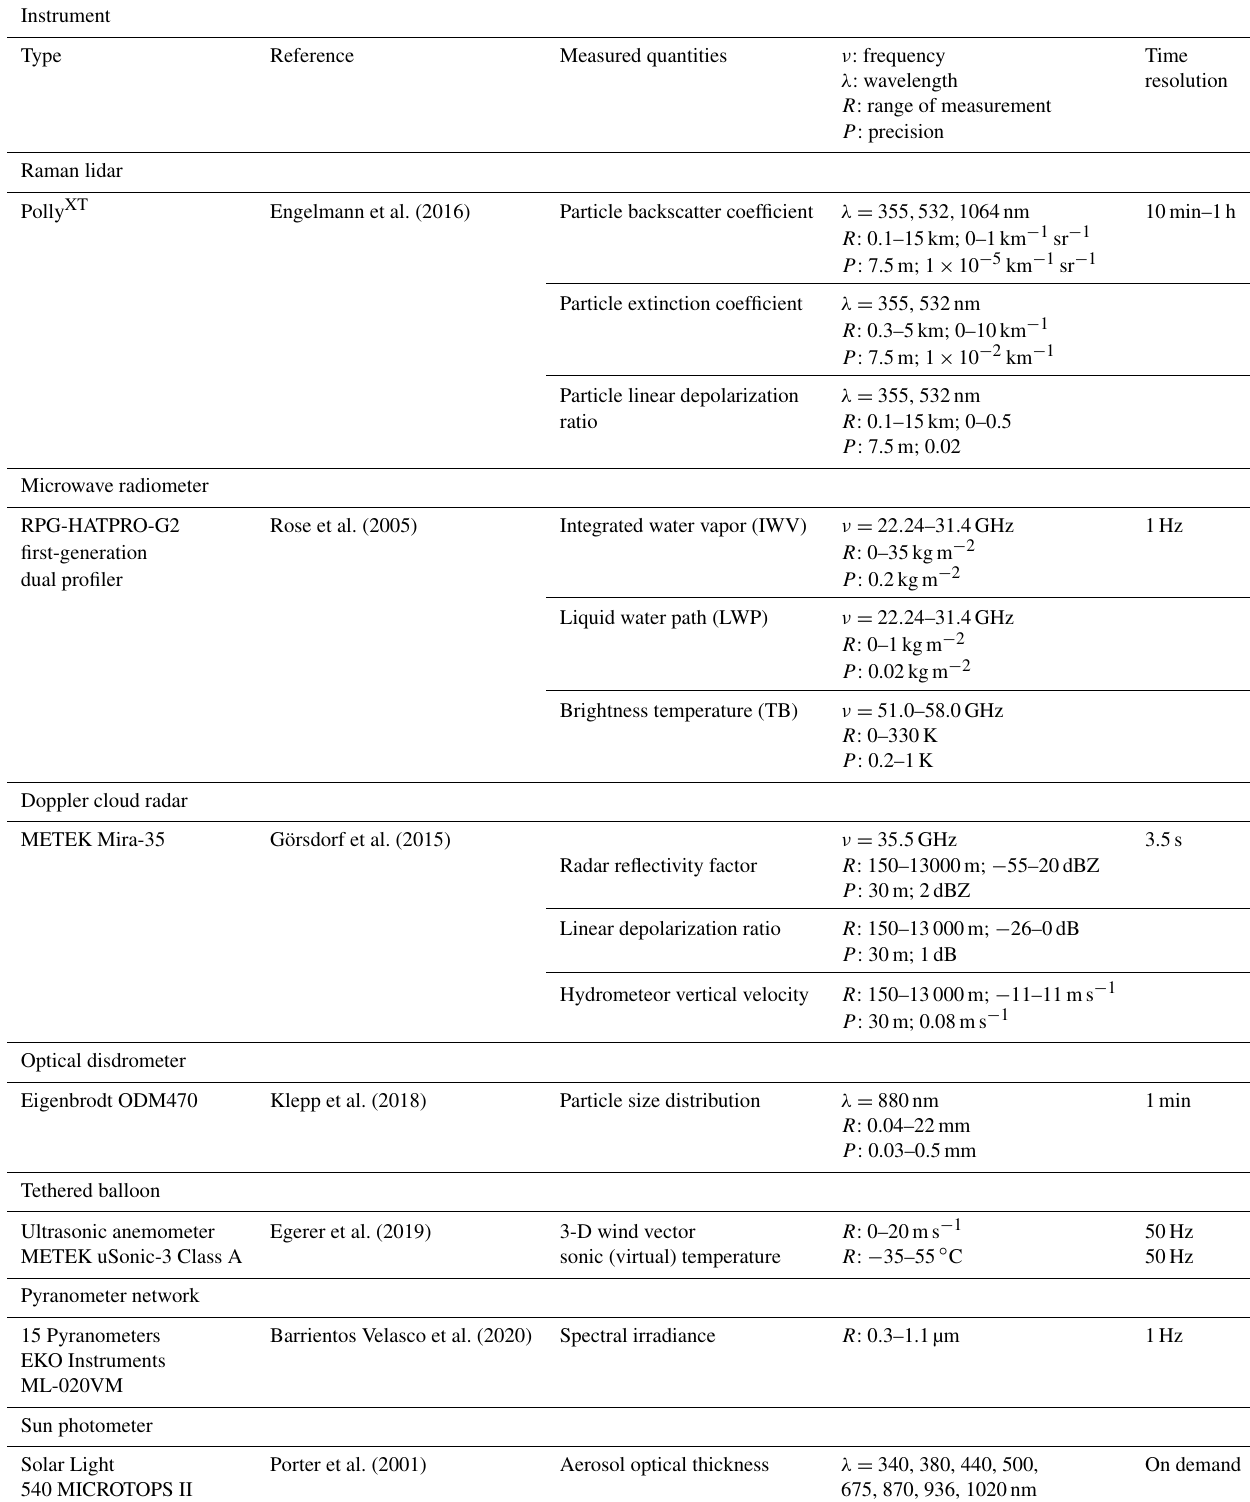
Table 1. Overview of the instrumentation deployed during PS106 that had been used for processing of the OCEANET observations.